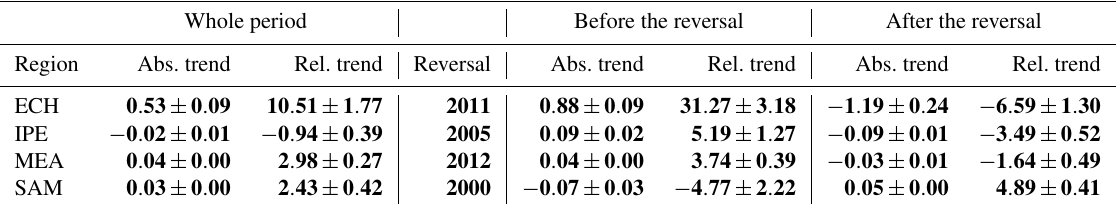
Table 1. Absolute trends (in 10 15 moleculescm − 2 yr − 1 ) and trends relative to the fitted mean of the first year (in %yr − 1 ) with the cor- responding uncertainties ( ± 1 σ ) for the period April 1996–September 2017 for four regions of interest: ECH (eastern China), IPE (Iberian Peninsula), MEA (the Middle East), and SAM (southeastern America). The year when a trend reversal was detected and the absolute and relative trend for the sub-period before and the sub-period after the detected trend reversal are also given. The year of reversal is included in both sub-periods, while the relative trends are calculated relative to the fitted mean of each sub-period’s first year. Bold characters are used to indicate the year of reversal and the statistically significant trends at the 95% confidence level. Whole period Before the reversal After the reversal Region Abs. trend Rel. trend Reversal Abs. trend Rel. trend